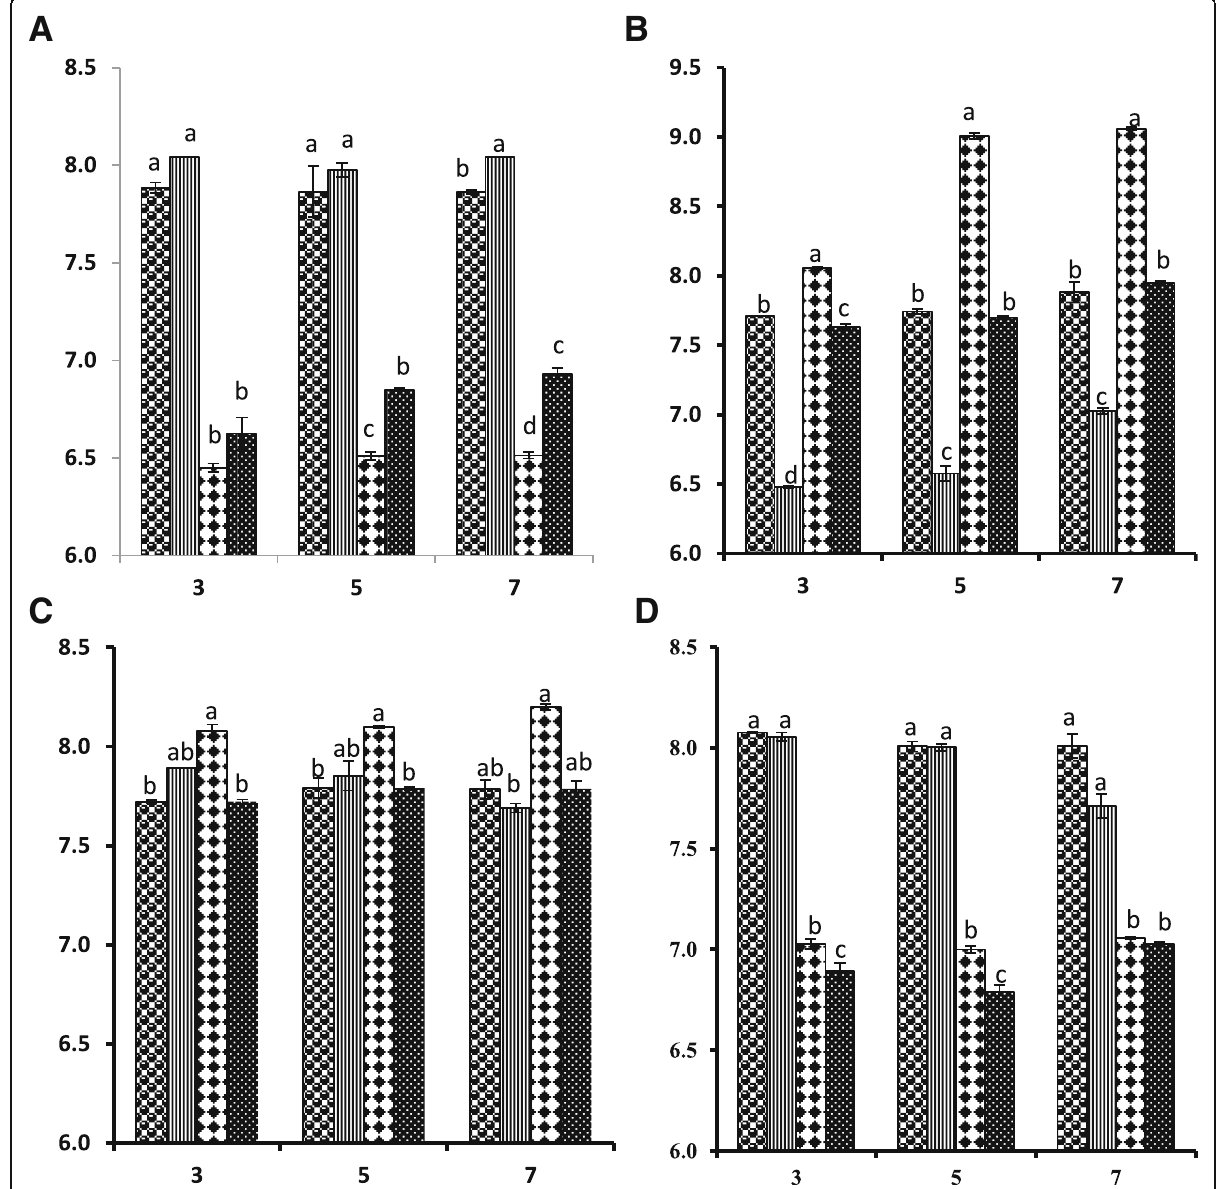
Fig. 3 Effect of LM infection and LB treatment on intestinal microbial composition of mice. TPC (Total Plate Count); LAB (Lactic Acid Bacteria); APC (Anaerobic Plate Count) and Coliform count were represented by a , b , c and d respectively. Data was analyzed using One way ANOVA followed by DMRT. Bars having no common letters are significantly different from each other at ( P ≤ 0.05). Error bars represent Standard error of mean. Y-axis presents log CFU/g and X-axis Day post infection